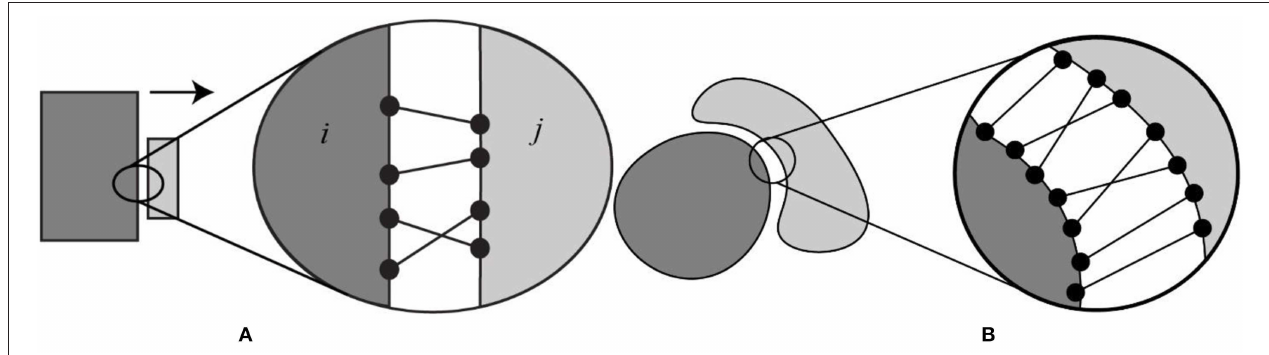
FIGURE 1 | Schematic presentation of the protocol used to separate the binding partners in protein-protein complex. (A) Hypothetical case with a flat binding interface and (B) case of a binding interface which is not flat. Black dots show the atom pairs across the binding surface that lie within some cut-off distance. Atoms pairs are connected with black